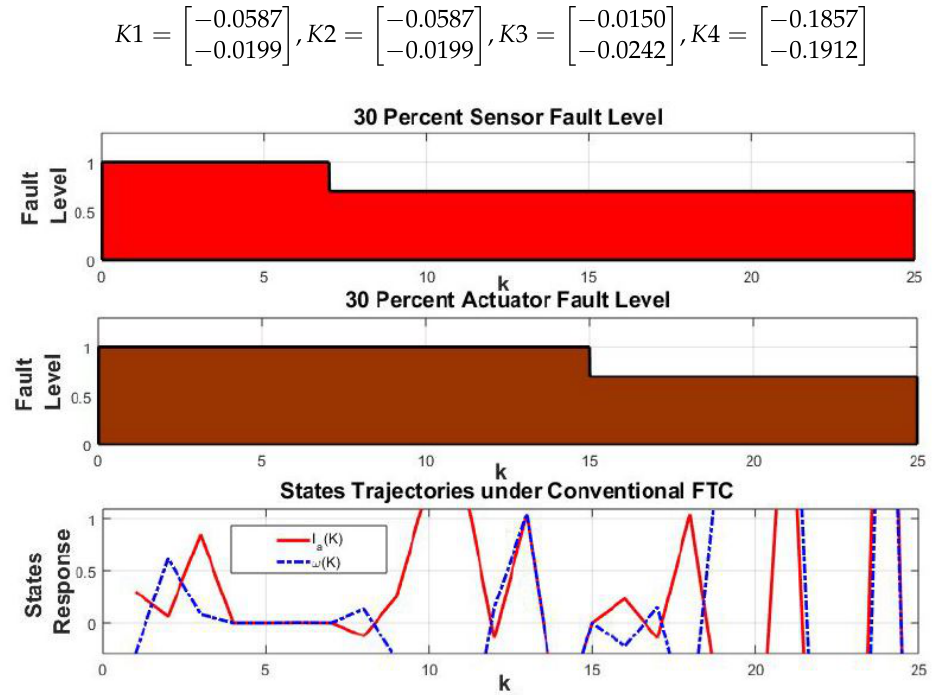
Figure 8. State response of the networked DC motor system under normal